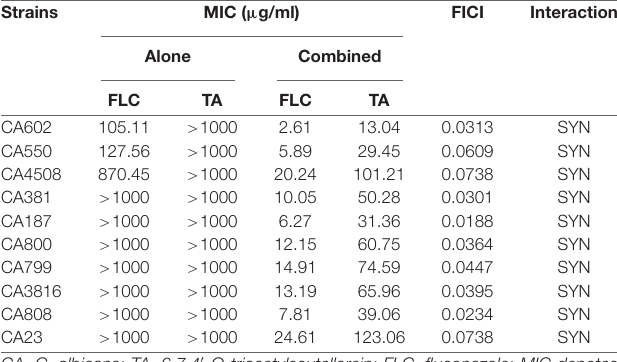
TABLE 3 | The effect of FLC combined with TA against C. albicans in vitro ( n =